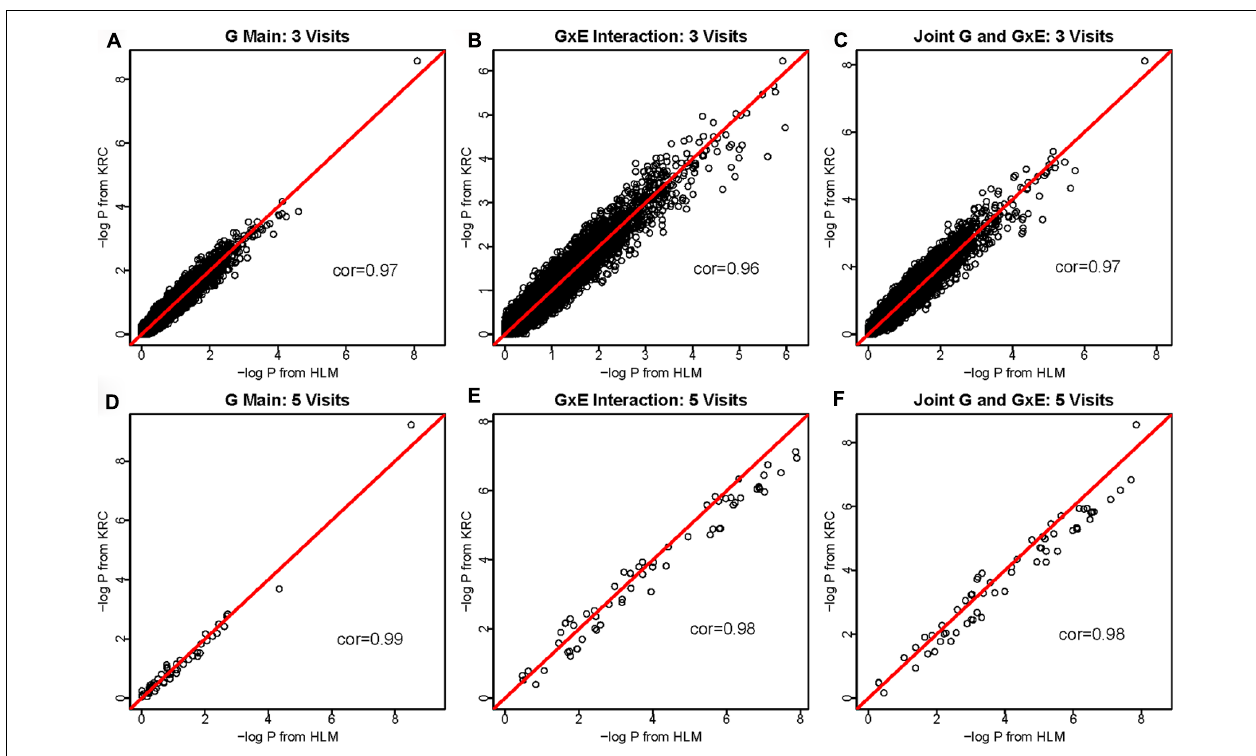
FIGURE 1 | − log( P ) values using the HLM ( x -axis) versus − log( P ) values using the KRC ( y -axis) for 3-visit and 5-visit data sets. Results from both methods were identical for 1-visit data (not shown). The 1st row corresponds to the 3-visit results ( A for genetic main